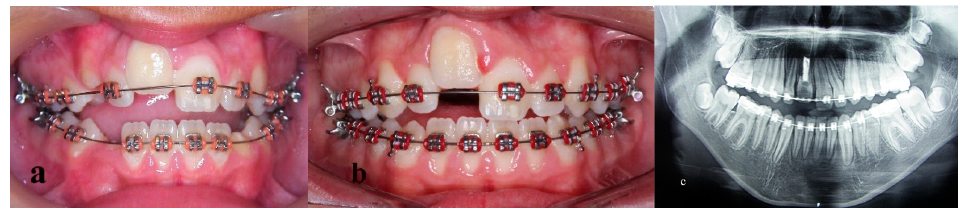
Figure 4. Treatment progress photographs during fixed appliance treatment. ( a ) Four months after treatment, ( b ) 12 months after treatment, ( c ) panoramic radiograph presenting adequate space for osteotomy.